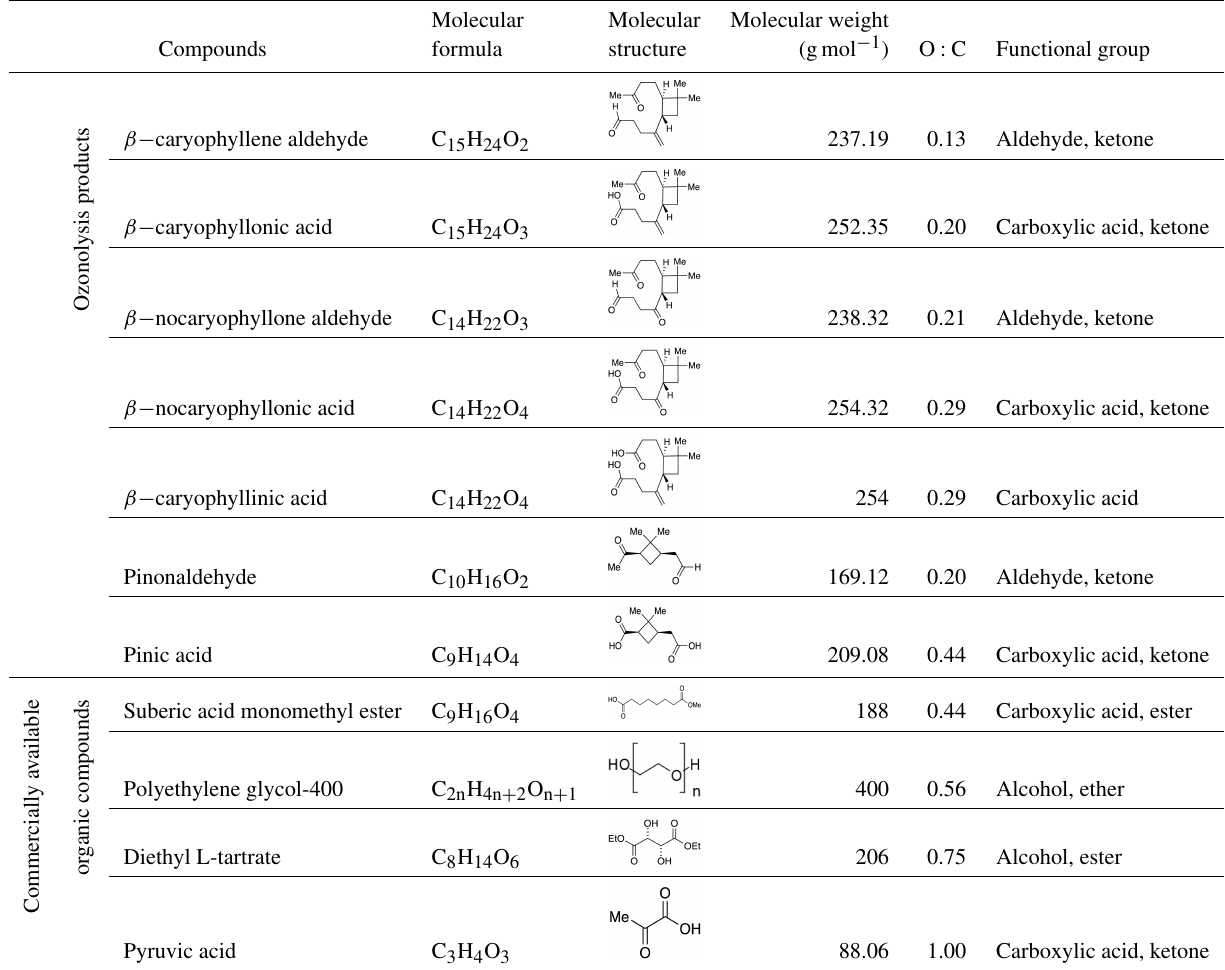
Table 1. Molecular formula, molecular structure, molecular weight, oxygen-to-carbon elemental ratios (O : C), and functional groups of organic compounds studied. All compounds are liquid at room temperature. Molecular Molecular Molecular weight Compounds formula structure (gmol − 1 ) O : C Functional